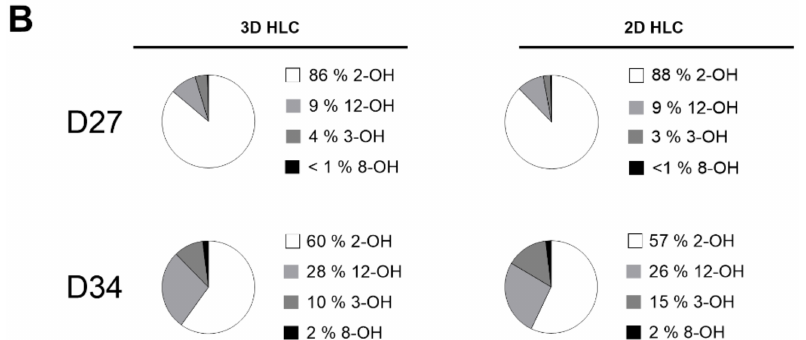
Figure 4. ( A ) Levels of NVP Phase I and II metabolites in 3D- and 2D-HLCs after 3 (D27) and 10 days (D34) of NVP treatment. hnMSC cultured in monolayer and exposed to NVP for 3 days are also shown and ( B ) relative proportions of total NVP metabolites (free metabolites + sulfate conjugates + glucuronic acid conjugates) at D27 and D34. The data (Mean ± SD, n = 3) are normalized to total cell number. Table 1. Comparative summary of 3D- and 2D-HLC metabolic capacity upon 10 days of NVP treatment (D34).